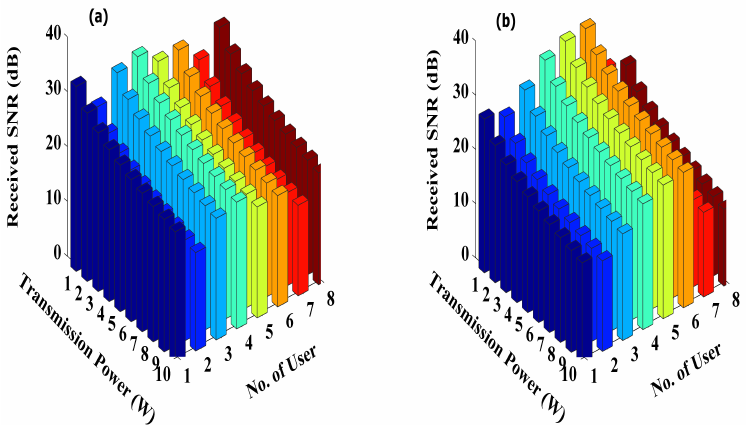
Figure 6. Estimated average received signal-to-noise ratio (SNR) when both gyre decoding and inverse T-transformation schemes are ( a ) absent and ( b ) present.